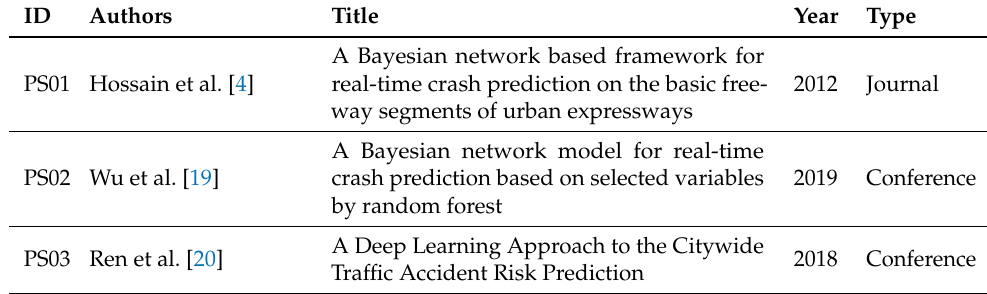
Table 2. Selected primary